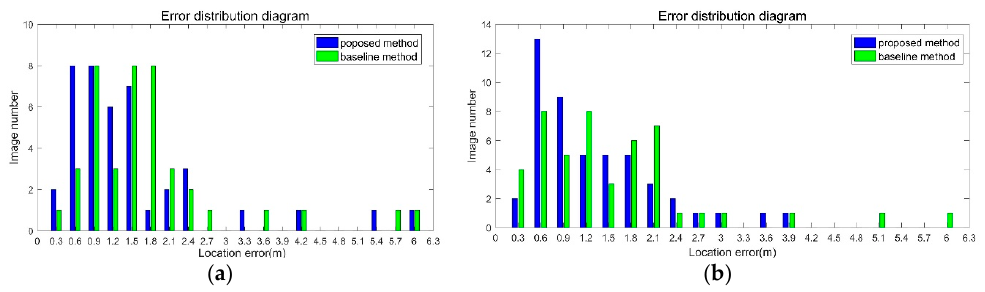
Figure 13. The location error distribution diagram of dataset 2. ( a ) Samsung dataset result. ( b ) iPhone dataset result.